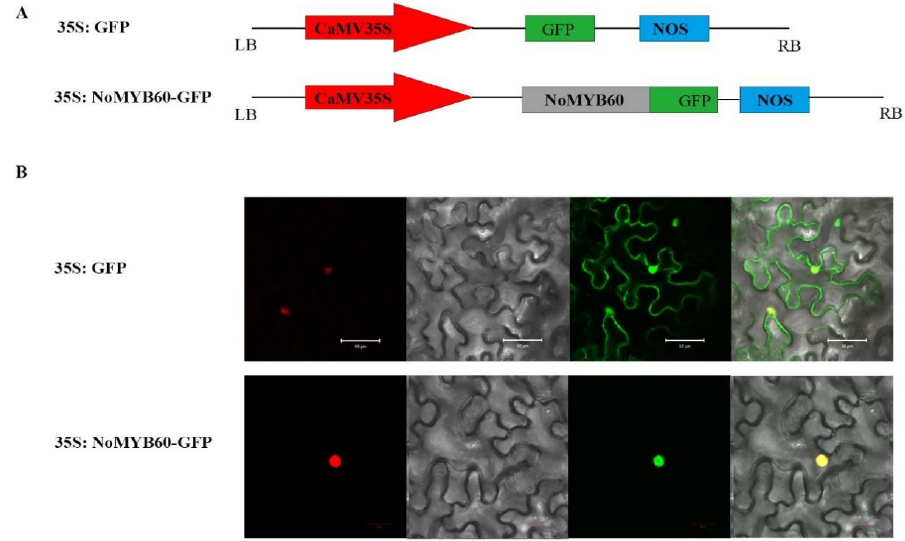
Figure 4. Subcellular localization of NoMYB60. ( A ) The construct of 35S:NoMYB60-GFP fusion protein; ( B ) localization of 35S:NoMYB60-GFP in tobacco leaves was observed under a laser confocal microscope. The panels from left to right show mCherry (nuclear marker), bright field, fluorescence and merged fluorescence images.